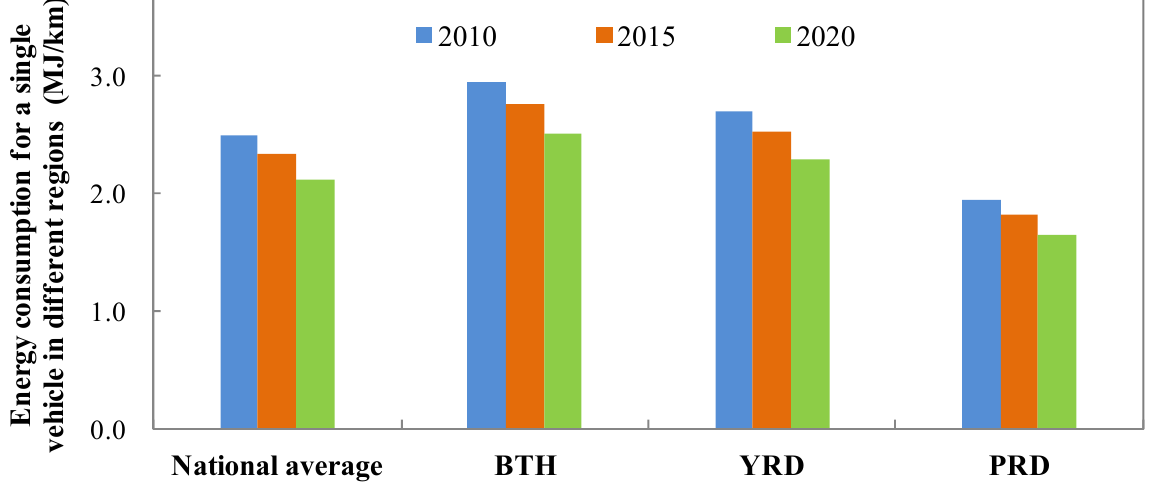
Table 9. The energy consumptions of China in other studies (MJ/km) [16,52].